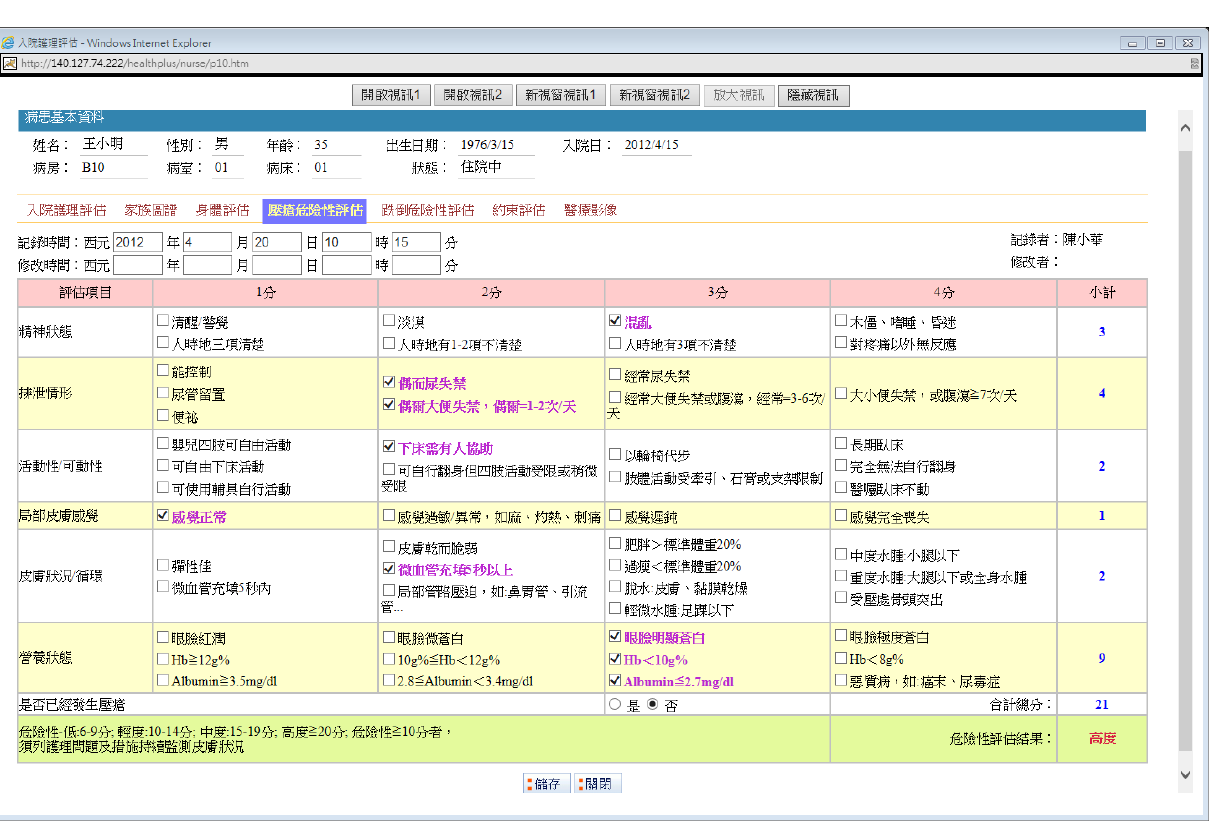
Figure 4. Decubitus ulcer’s risk assessment